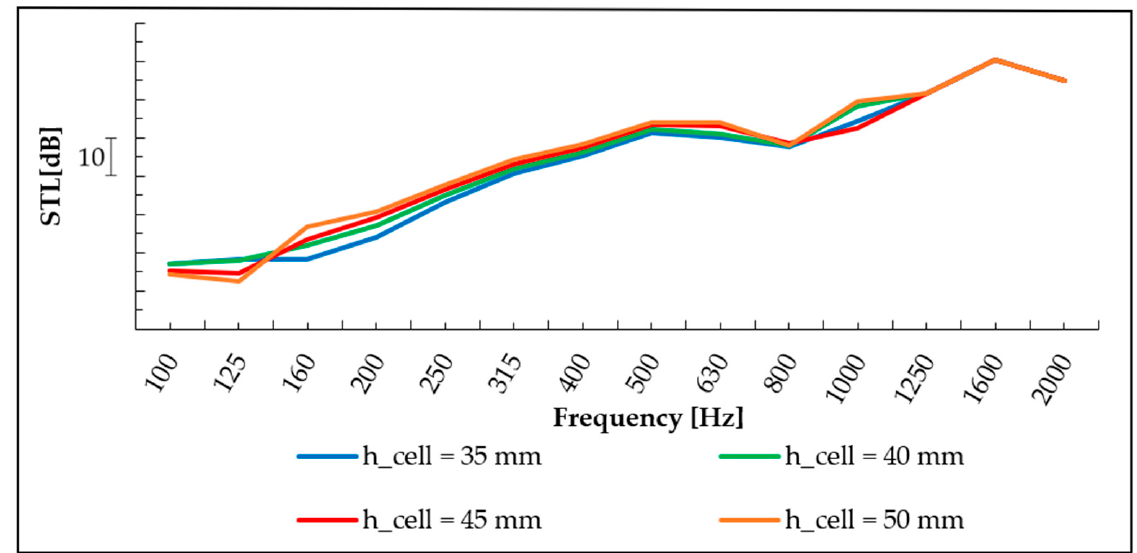
Figure 5. STL numerical results keeping the nominal dimensions for a cell and tck panel and varying h cell .